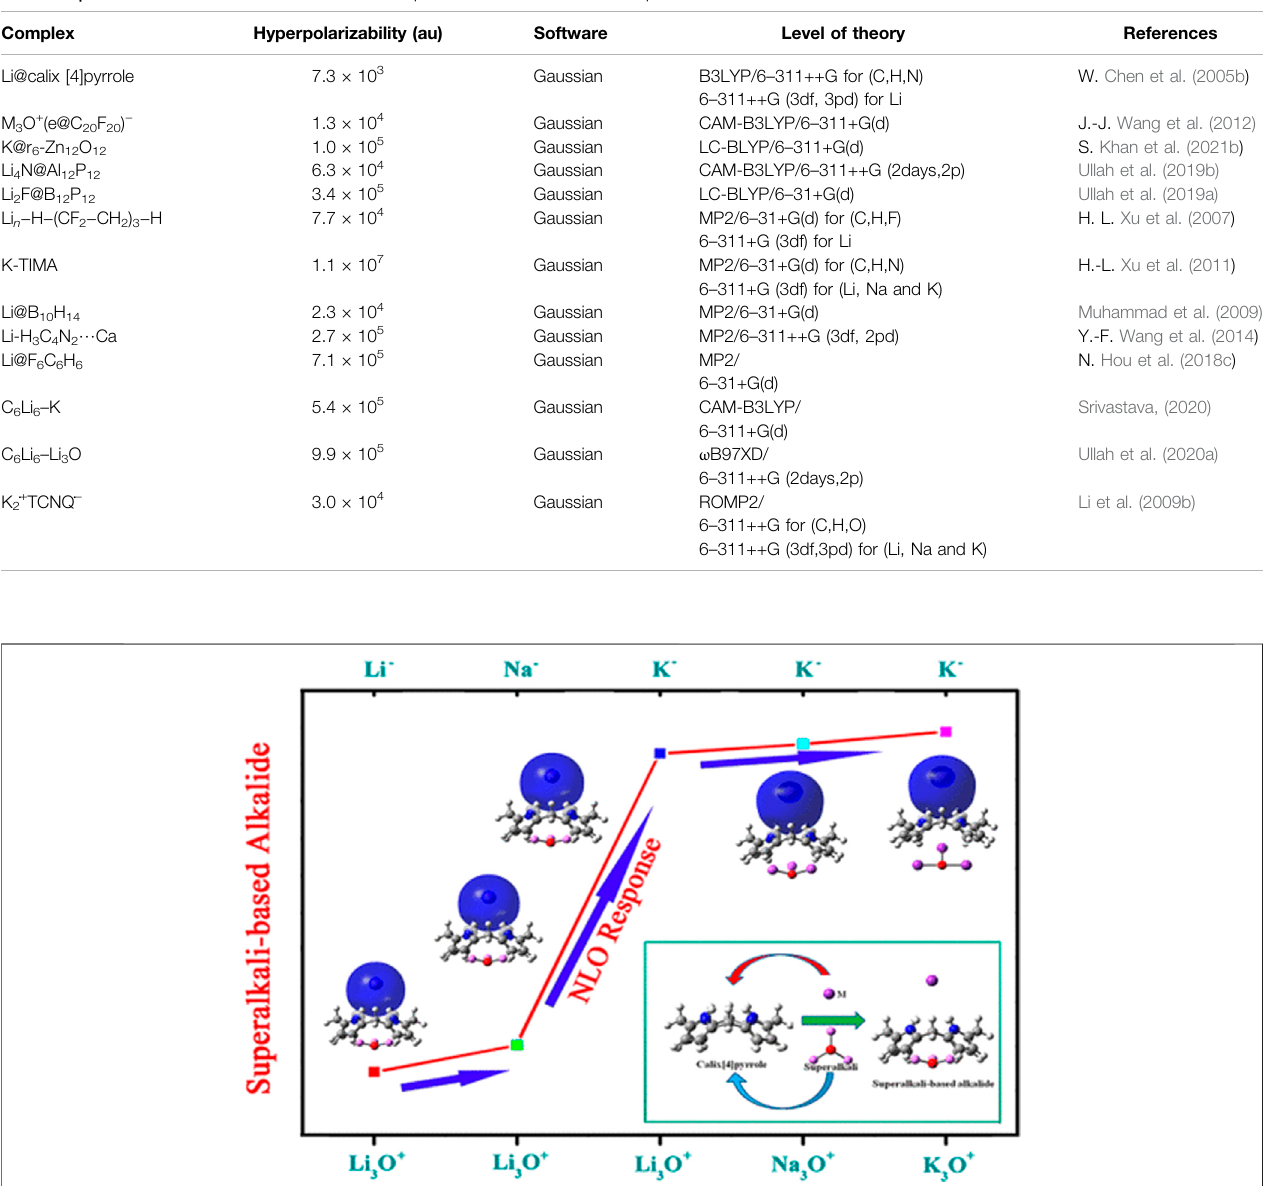
Frontiers in Materials |